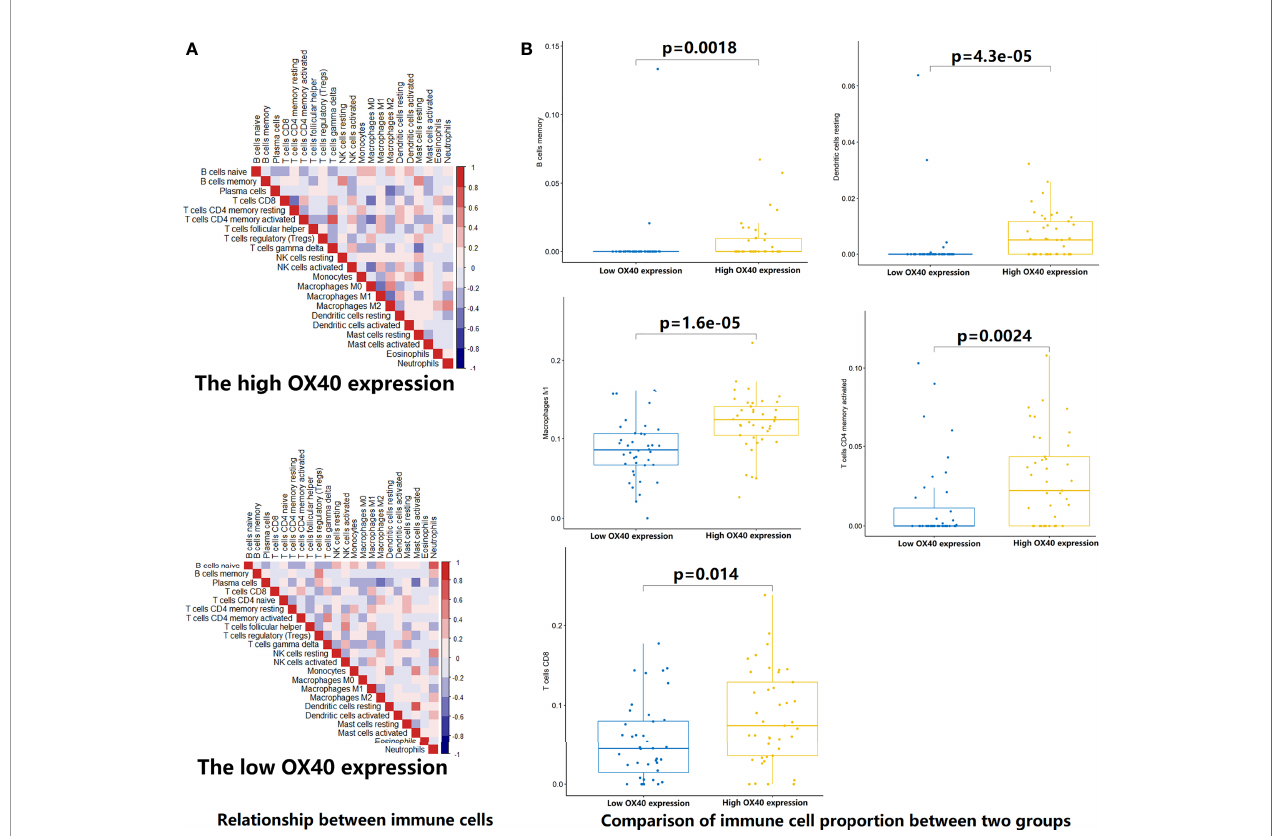
FIGURE 6 | Estimation of relative in fi ltration proportions of 22 kinds of immune cells in the high and low OX40 expression group. (A) By the CIBERSORTx algorithm, relationship matrixes of 22 immune cells in small cell lung cancer patients wit h high and low OX40 expression. (B) The high OX40 expression group presented increased in fi ltration of 5 kinds of immune